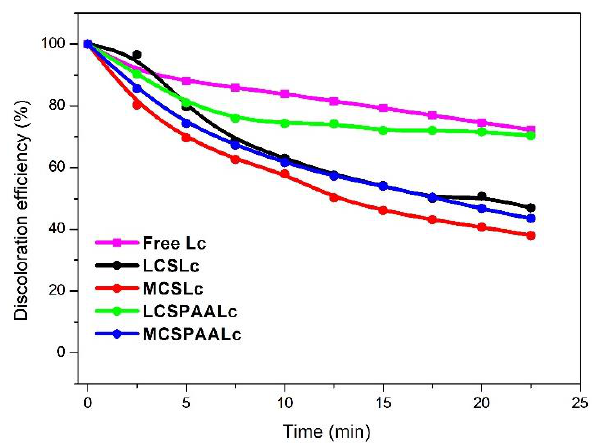
Figure 9. Degradation reaction of MR in the presence of free or immobilized Lc M and ABTS.